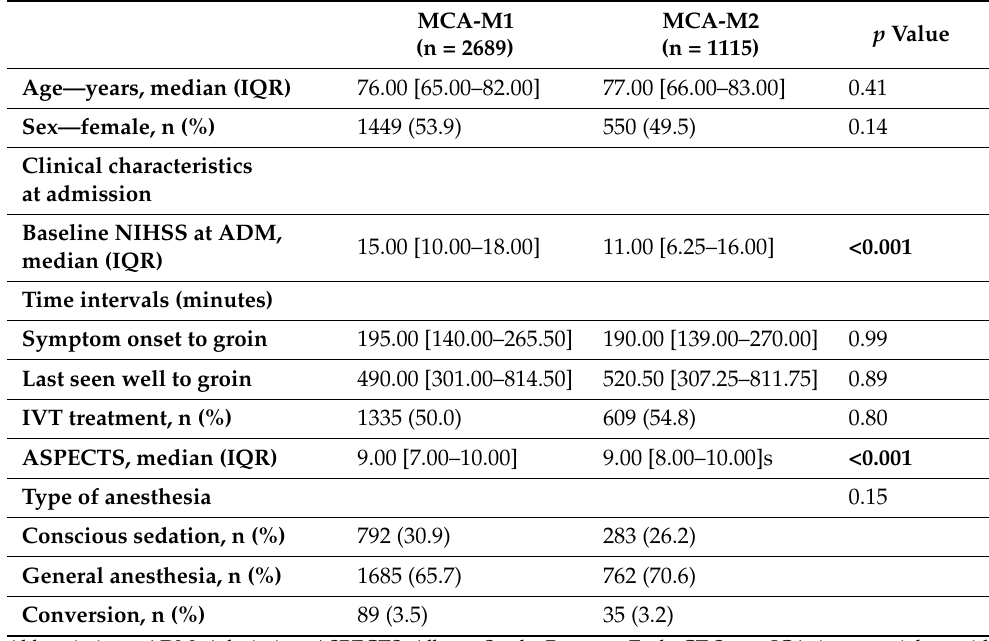
Table 1. Baseline characteristics MCA-M1 vs. MCA-M2.